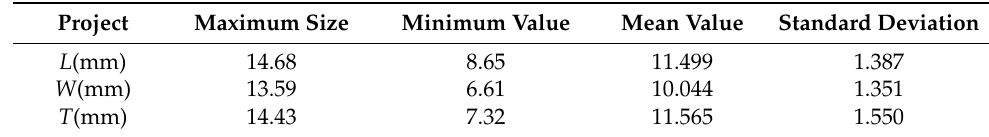
Figure 2. Sizes of tiger-nut tubers. Table 1. The results of the triaxial dimensions statistical analysis of tiger nuts.